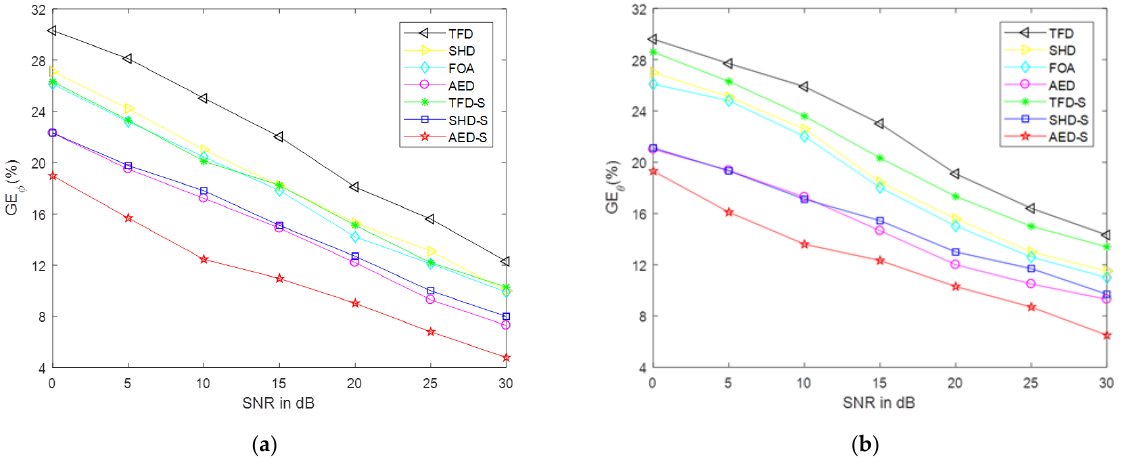
Figure 8. GE for estimation against SNR with the threshold λ = 20. ( a ) is the GE for azimuth against SNR. ( b ) is the GE for elevation against SNR.